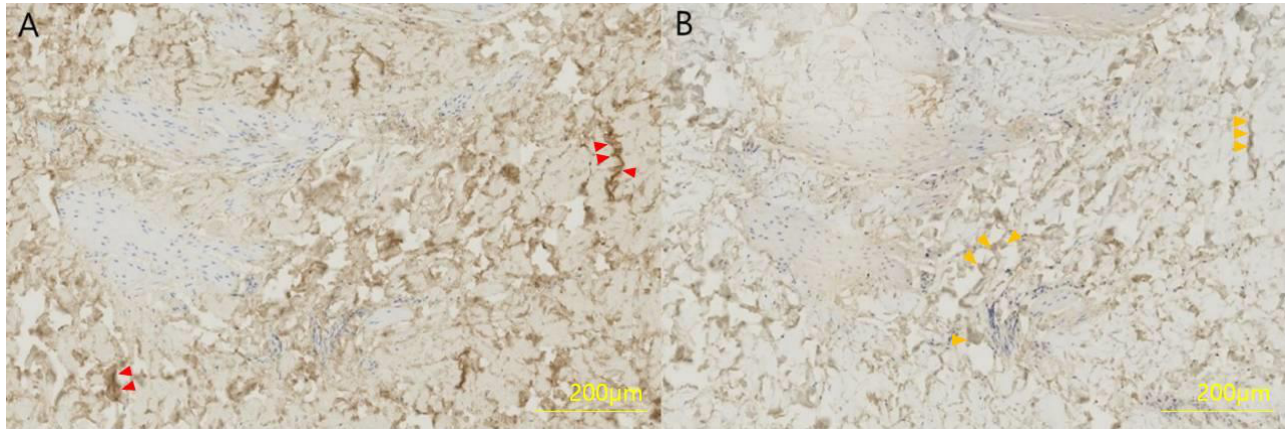
Figure 2. Immunohistochemistry of a full-thickness skin specimen from a 46-year-old woman. ( A ) Collagen type I and ( B ) collagen type III were formalin-fixed, paraffin-embedded and stained with a polyclonal antibody at a dilution of 1:100 for 4 h. Collagen type I is stained brown (red arrows) and collagen type III is stained light brown (orange